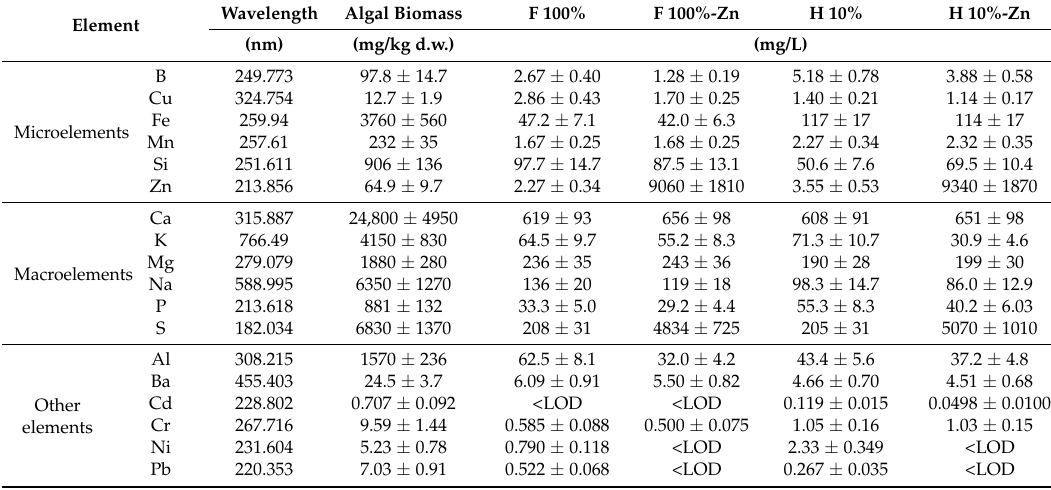
Table 1. The multi-elemental composition ( N = 3) of the algal biomass, algal filtrate and homogenate (average ± standard deviation;